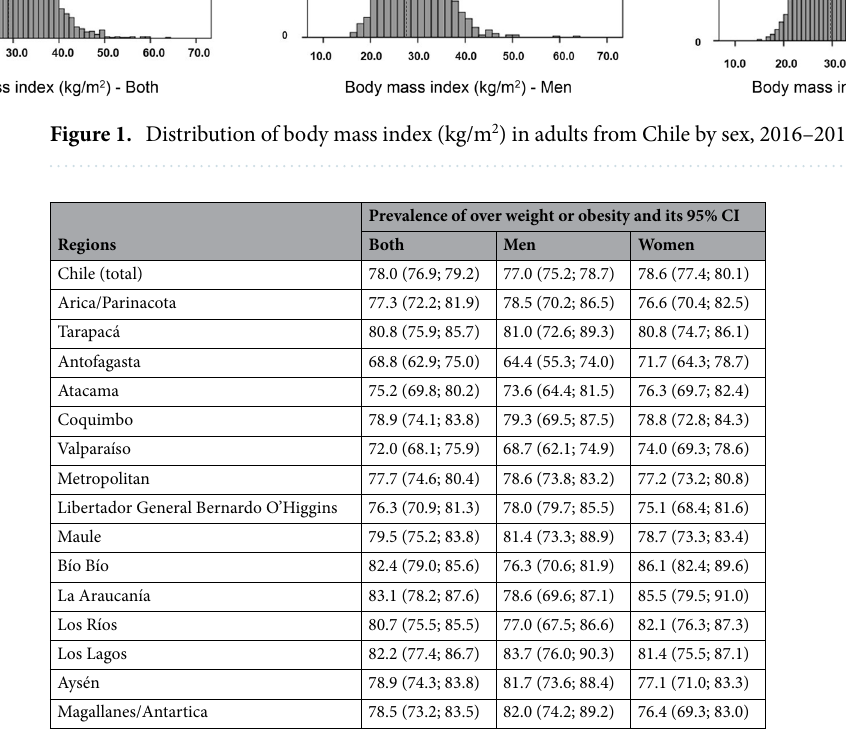
Table 1. Prevalence of overweight or obesity (≥ 25 kg/m 2 ) by region in Chile. 95%CI confidence interval 95%.